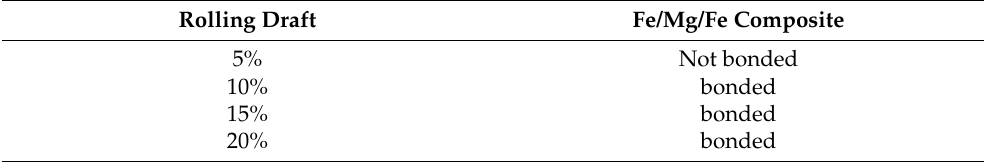
Table 1. Roll-clad results of Fe/Mg/Fe composite.